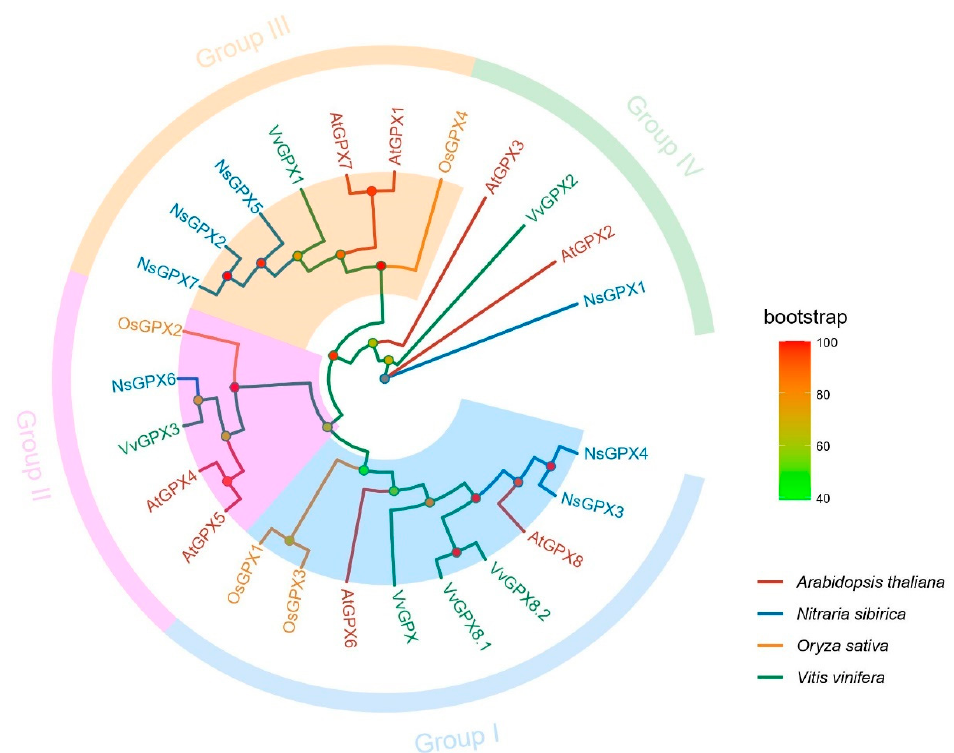
Figure 1. A neighbor-joining Phylogenetic analyses of 25 plant glutathione peroxidase (GPX) proteins. The plant GPXs include 8 AtGPXs (red), 5 OsGPXs (yellow), 6VvGPXs (green) and 7NsGPXs (blue), symbolized by unique colors.